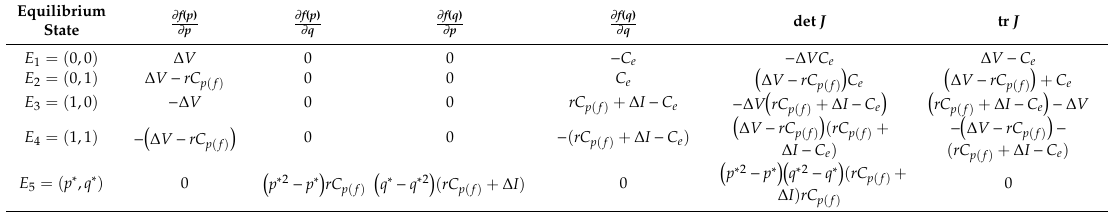
Table 2. Determinants and traces of the Jacobian matrix J for five potential ESSs under FPS. Equilibrium